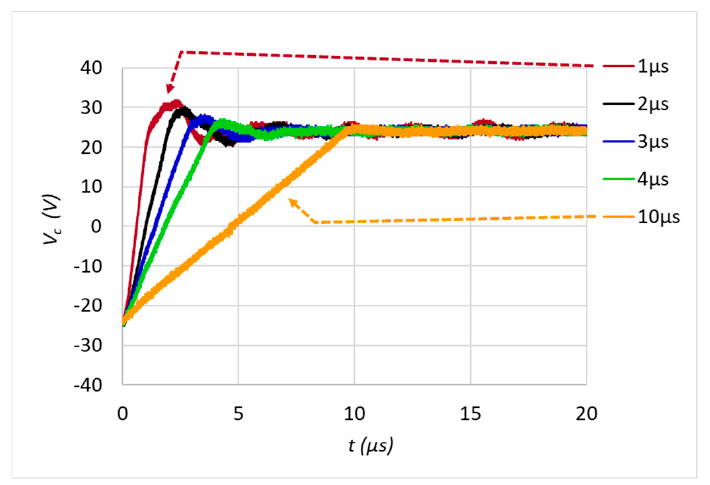
Figure 15. Measured transient voltage waveform of the multilayer actuator attached to a rigid mass.